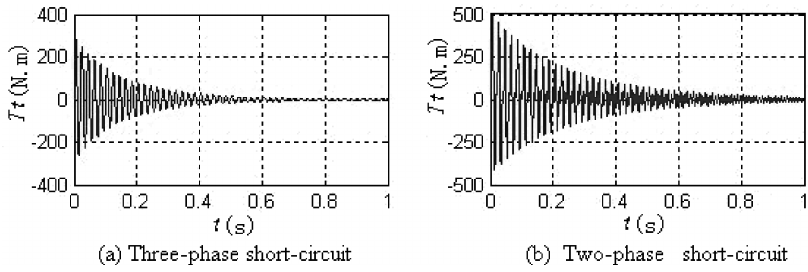
Fig. 5. Characteristics of the electromagnetic torques under the short-circuit faults.